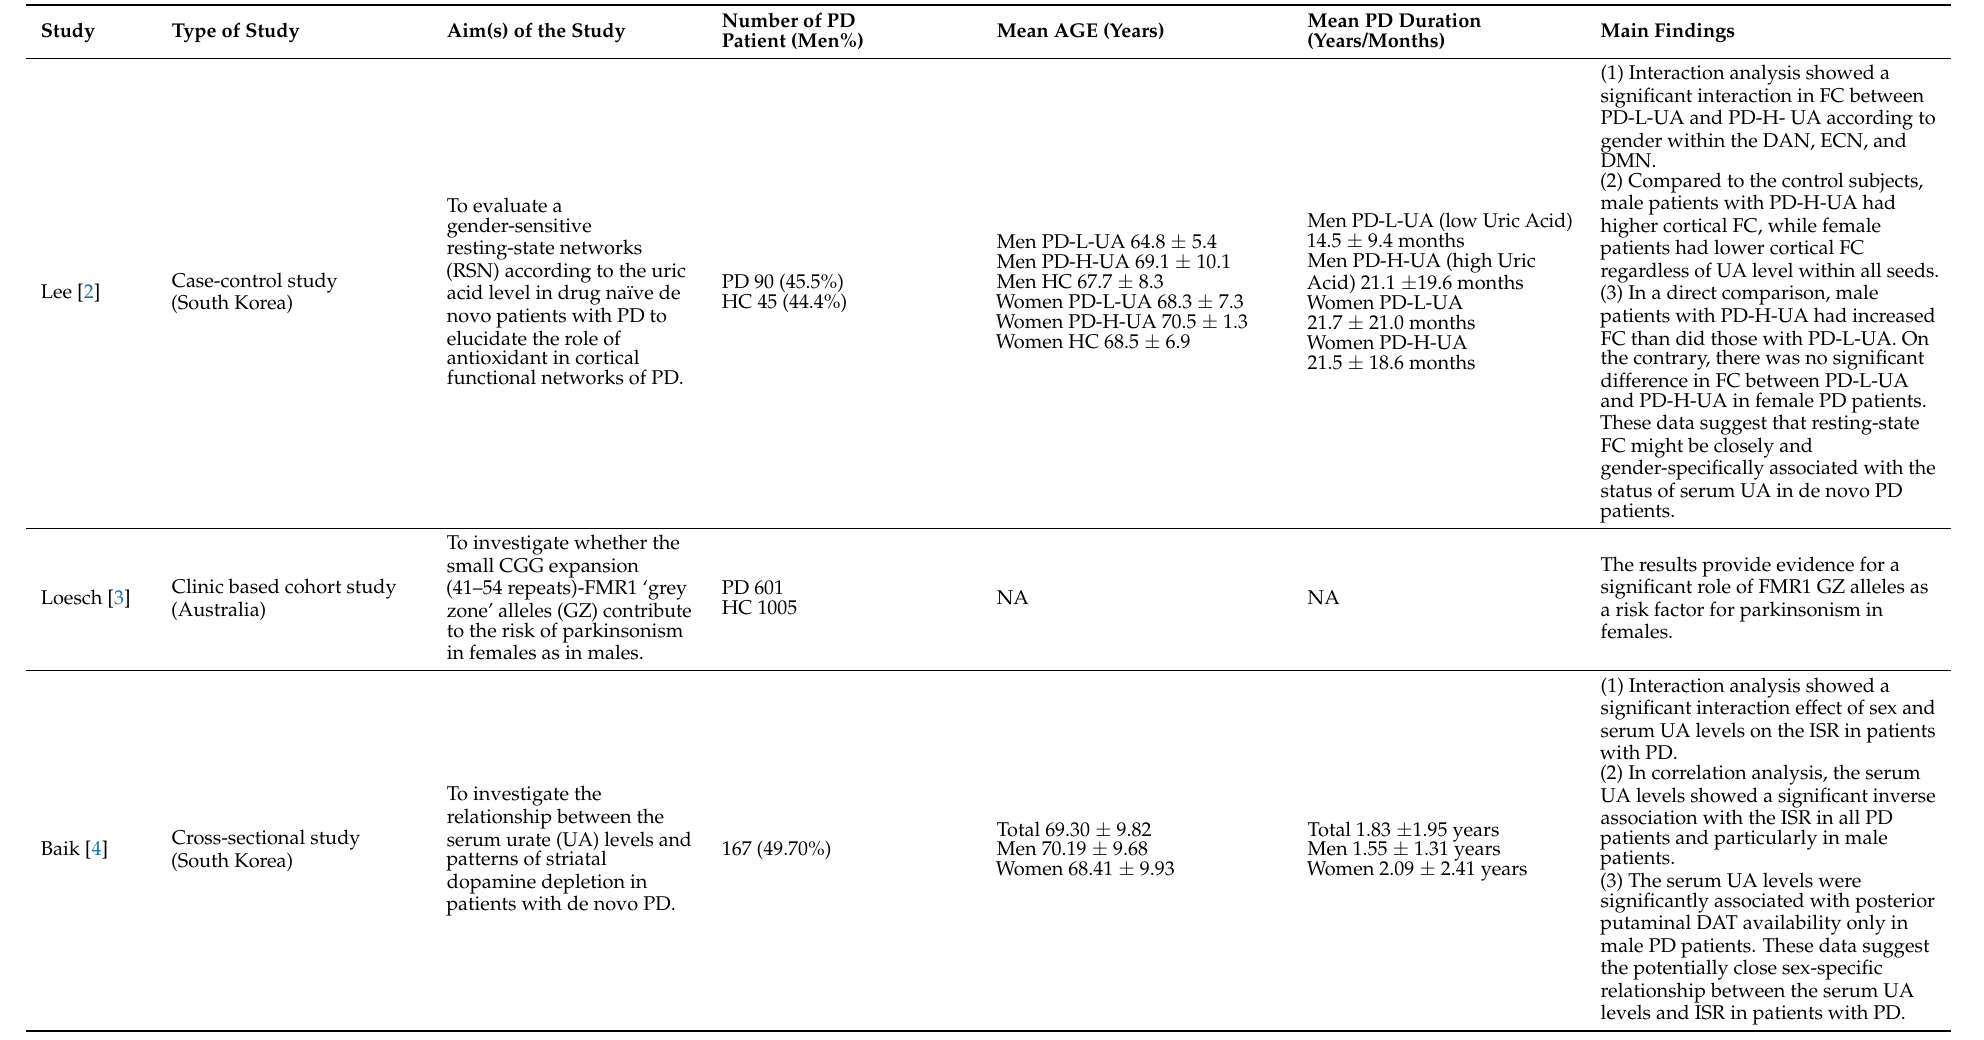
Table 1. Detailed results from studies on gender differences in PD reported in the paper from 2017 to